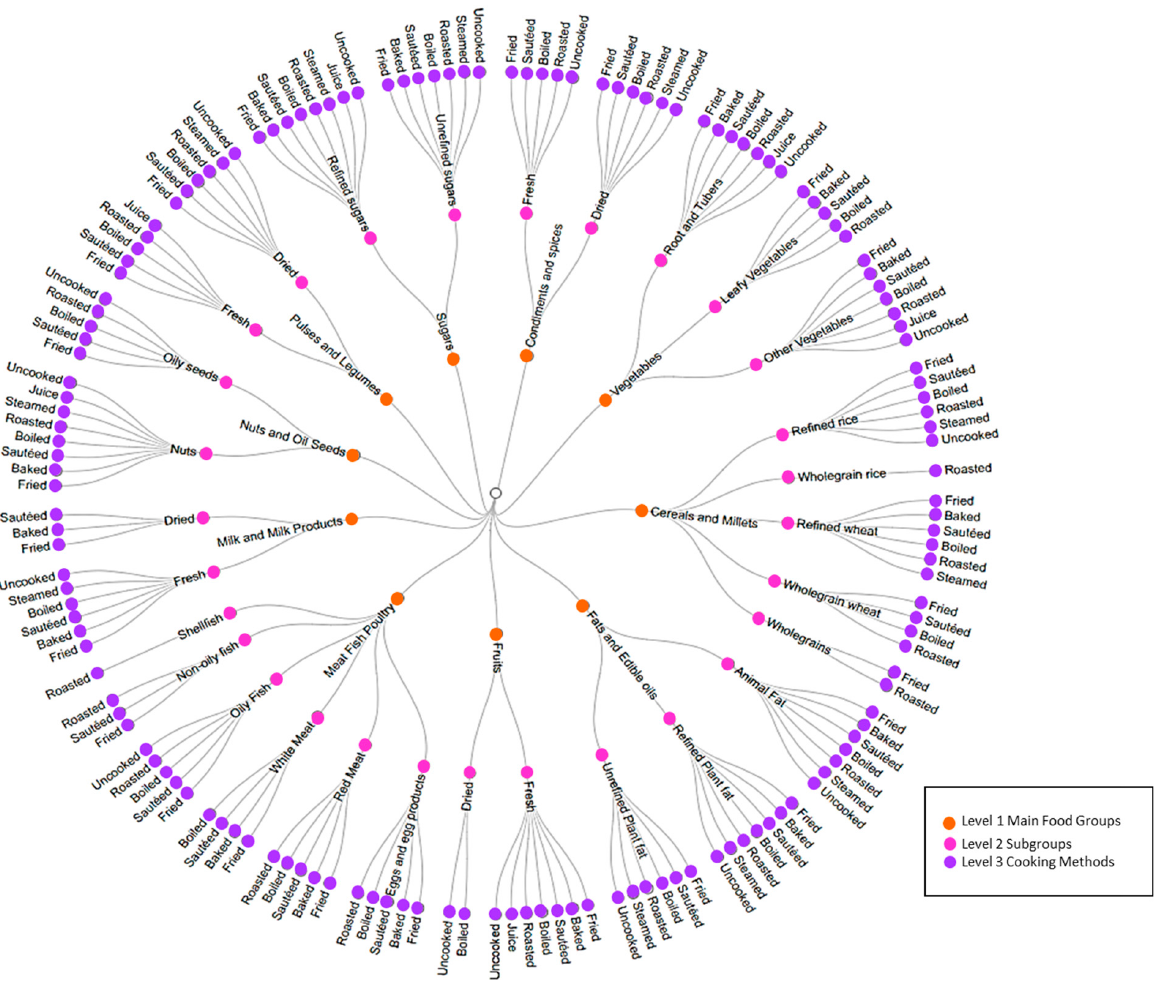
Figure 1. Representation of the food group levels based on the proposed food tree structure. Level 1 of the tree (inner circle) represents the 10 main food groups. Level 2 of the tree (middle circle) represents the 23 sub classifications related to each main food group in level 1. Level 3 (outer circle) represents the 8 cooking/processing methods related to sub classifications in level 2.